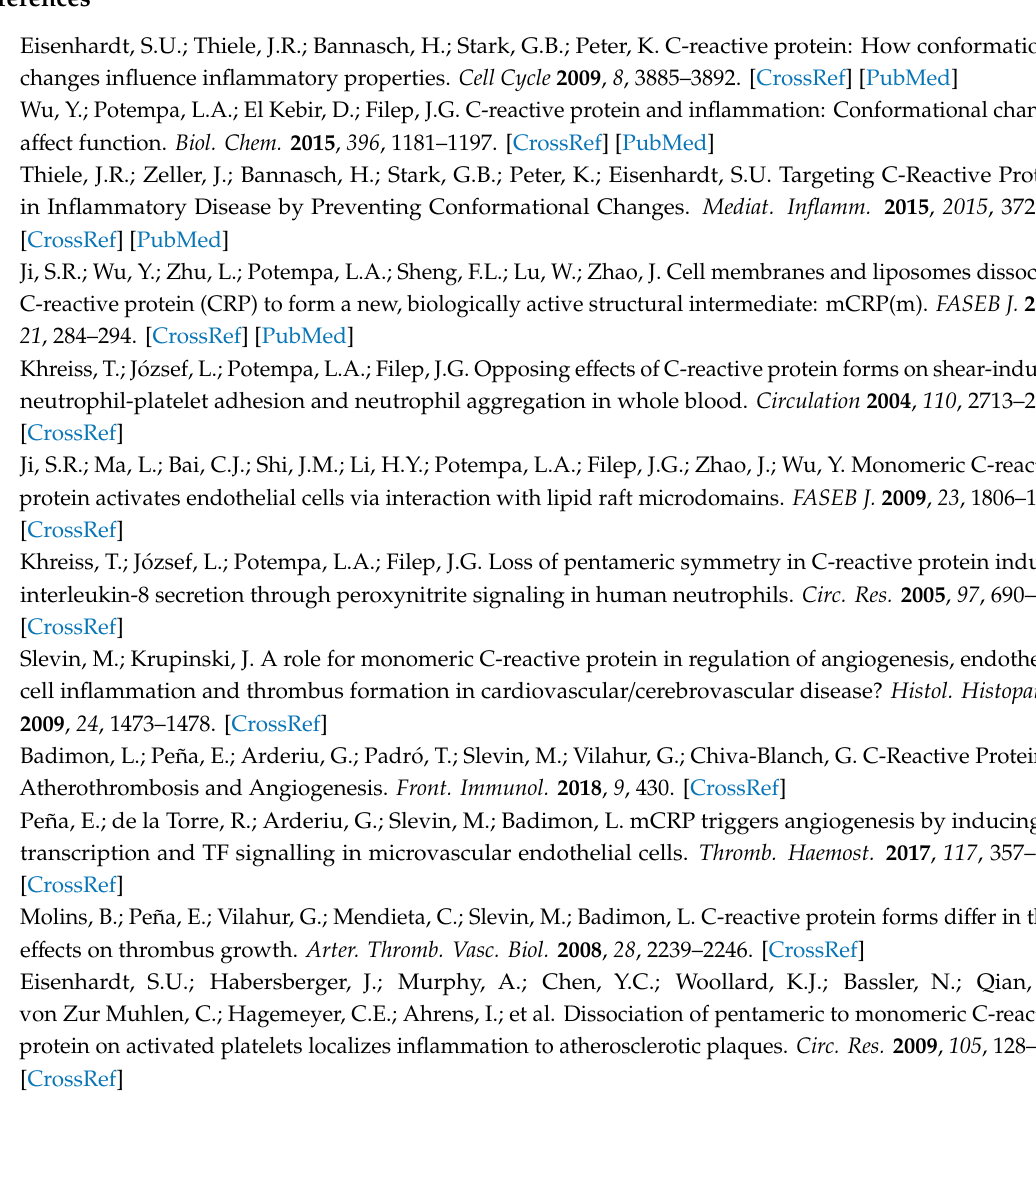
Table S1: Clinical characteristic of the CAD patients, Table S2: Primers used for RT-PCR, Table S3: The accession numbers for CRP primers, Figure S1: A schematic representation of the interaction of monoclonal antibodies to mCRP and pCRP with their